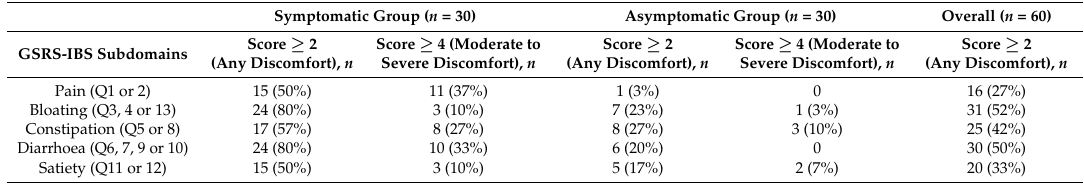
Table 2. Number of symptomatic and asymptomatic participants reporting any discomfort and moderate to severe discomfort in the five subdomain of the GSRS-IBS